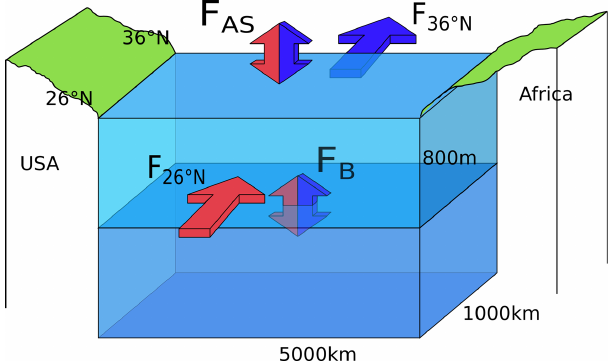
Fig. 1. Sketch illustrating the box model. Red and blue arrows in- dicate heat flux into and out of the box at 26 ◦ and 36 ◦ N, with the sign convention positive into the box. The blue/red arrows represent the air–sea surface flux and the mixing at the interface. There are no fluxes through the eastern and western